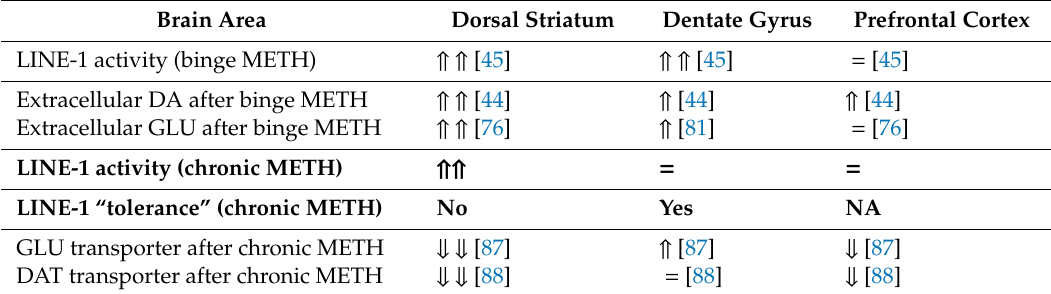
Table 1. The e ff ects of METH on LINE-1 activity and extracellular levels of dopamine and glutamate in the dorsal striatum, dentate gyrus, and prefrontal